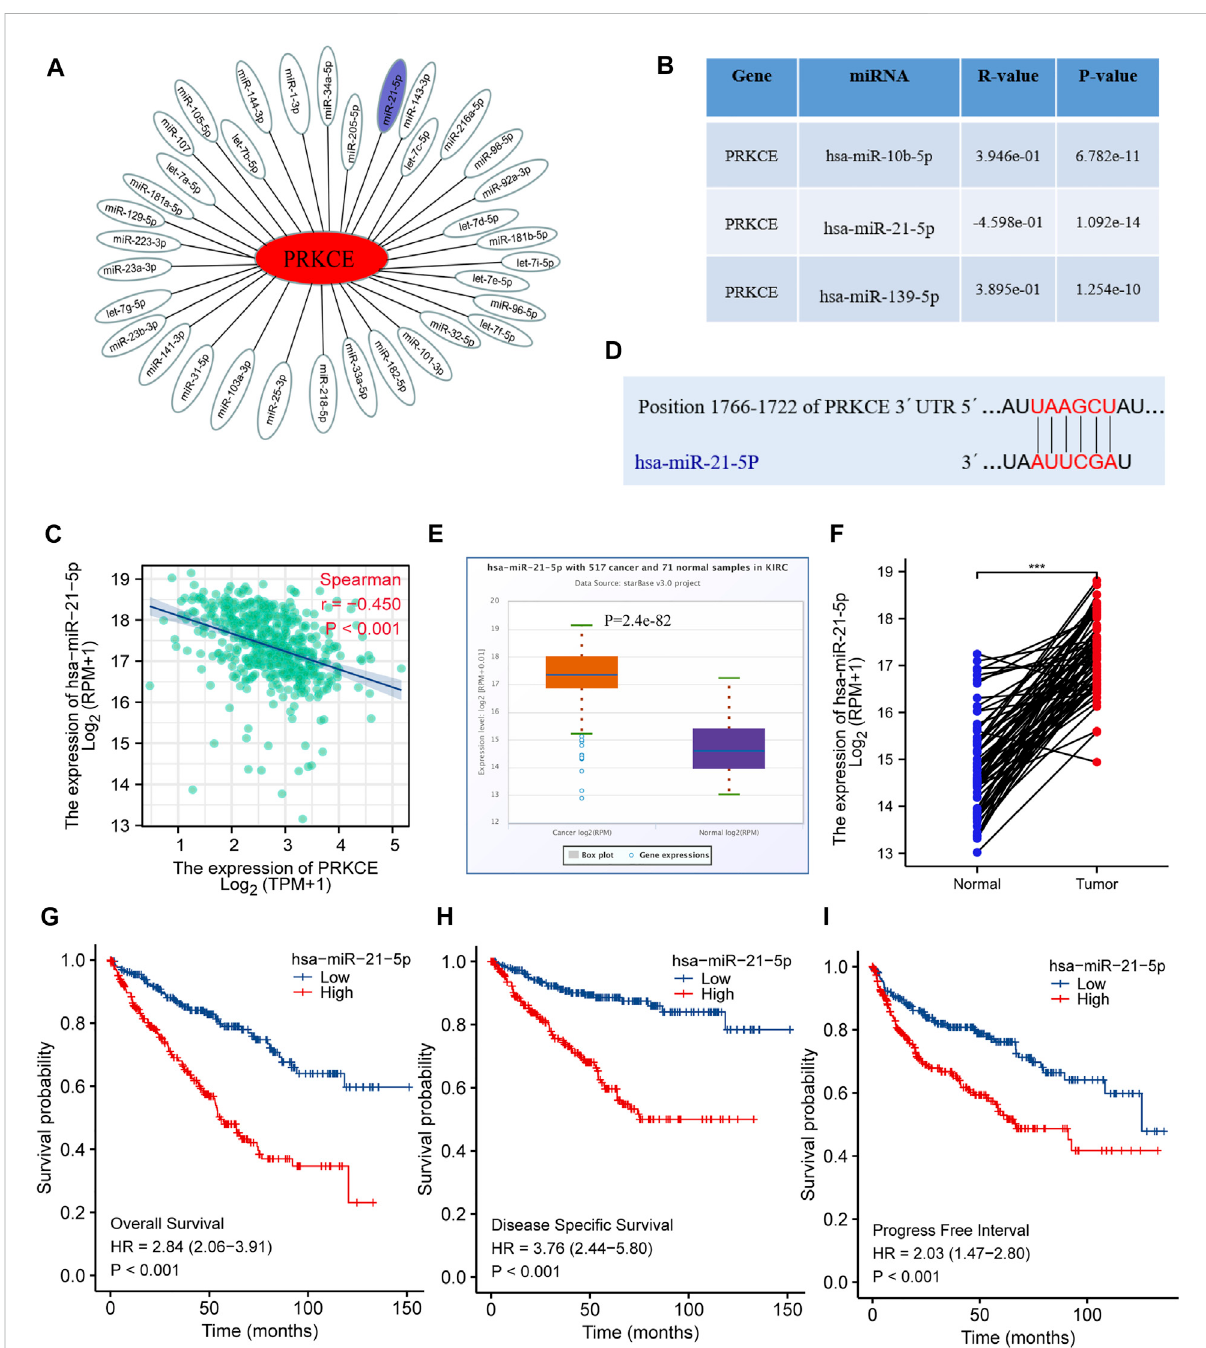
FIGURE 5 Identi fi cationofhsa-miR-21-5pasapotentialupstreammiRNAofPRKCE inKIRC. (A) ThemiRNA-PRKCEregulatorynetwork. (B) Thepredicted miRNAs of PRKCE were analyzed by miRactDB. (C) Scatter plots and correlation analysis between hsa-miR-21-5p and PRKCE in KIRC. (D) The target bind site in the PRKCE 3 ′ UTR was predicted by TargetScan. (E) The expression of hsa-miR-21-5p in KIRC and control normal samples was investigated by the starBase database. (F) TCGA database and statistical analyses of hsa-miR-21-5p expression in 71 pairs of KIRC tissues and adjacent normal tissues. (G – I) Survival curves of OS, DSS, and PFI between low and high expression of hsa-miR-21-5p in